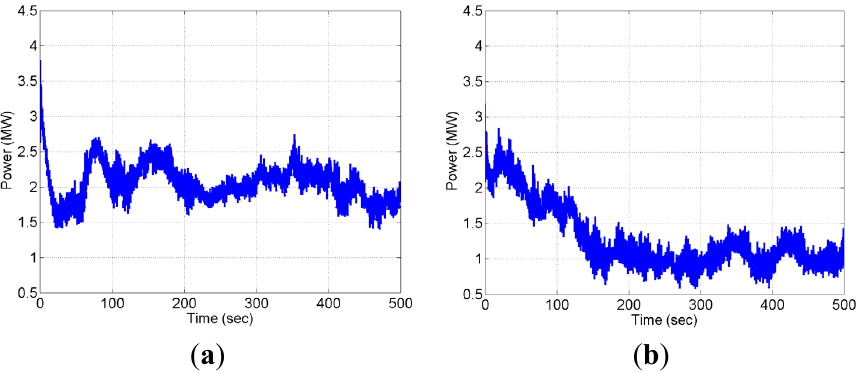
Figure 17. Time series of turbine power (5-Turbine Wind Farm, V Wind = 8 m/s).